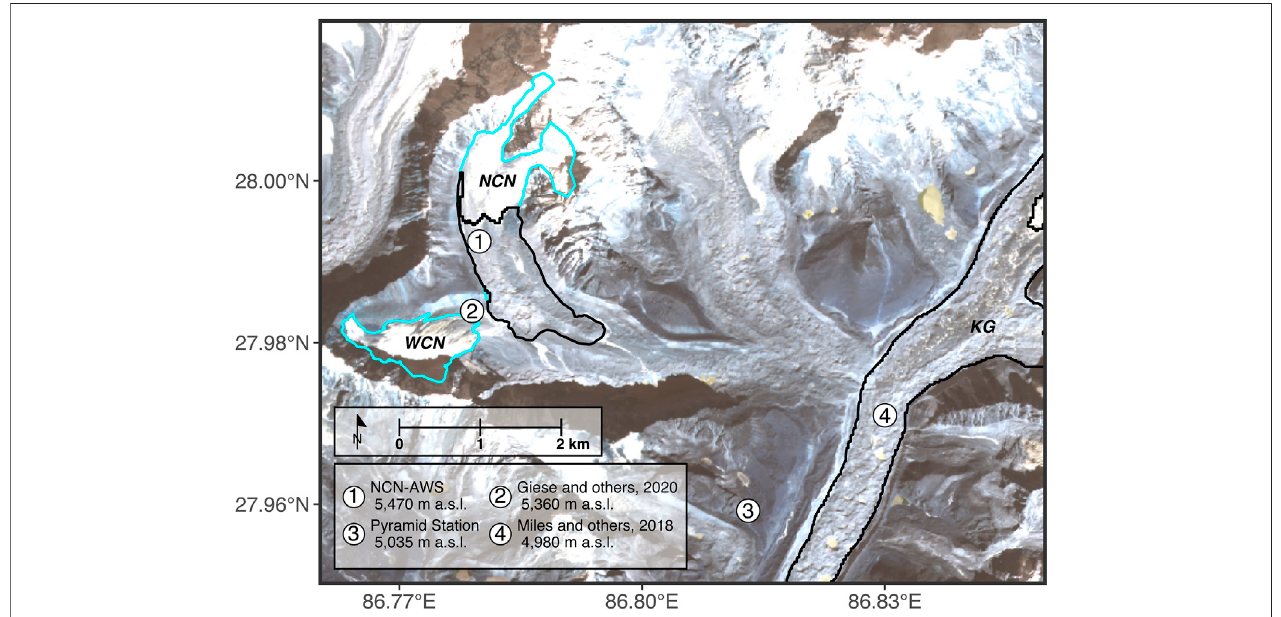
FIGURE 2 | Map of the study area. The acronyms WCN, NCN and KG stand for West Changri Nup, North Changri Nup and Khumbu Glacier. The sites where observational data were collected are numbered. The light blue and dark blue polygons are the outlines of the debris-free and debris-covered parts of the glaciers, respectively. The background image is a true colour composite of a Sentinel-2 Product level 1C image that was taken on 27 January 2021.